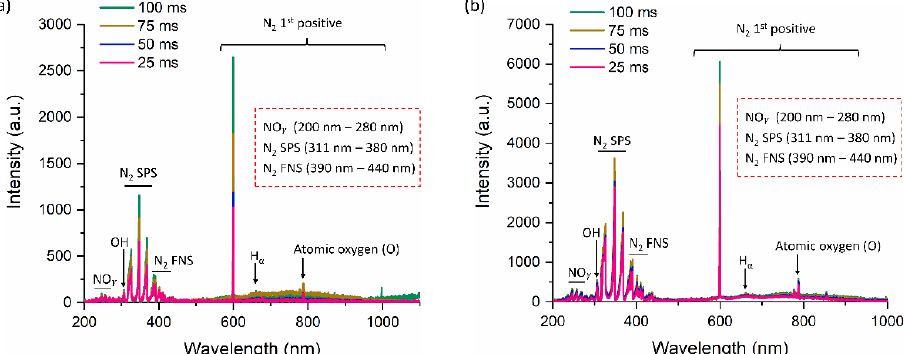
Figure 3. The OES spectra at plasma on-times of 25 ms, 50 ms, 75 ms, and 100 ms when the duty ratio was fixed at ( a ) 10% and ( b ) 36%.